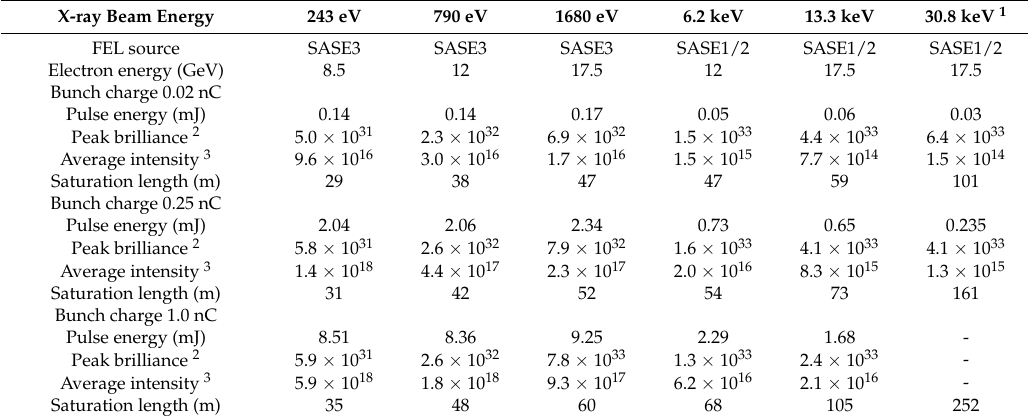
Table 3. FEL radiation properties at saturation for selected photon energies and electron parameters optimized for specific bunch charge working points